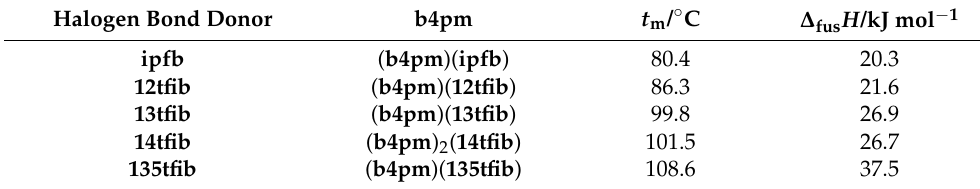
Table 1. The results of cocrystal synthesis by grinding and crystallisation from a solution of dike- tones and used halogen bond donors with melting points and enthalpies of fusion of the prepared